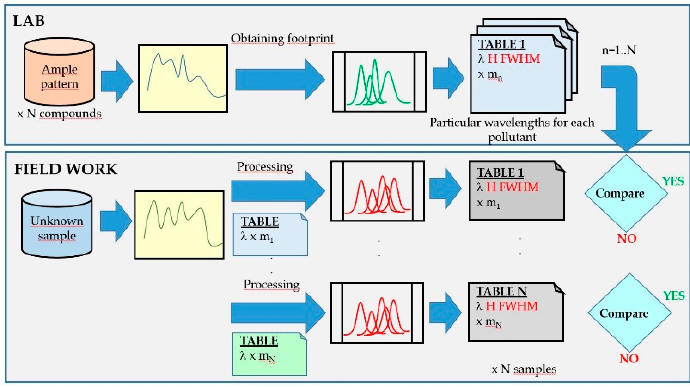
Figure 8. Detection scheme using fluorescence spectra by the trial and error comparison method: in the laboratory (upper part of the figure) and in the field analyzer (lower part of the figure).